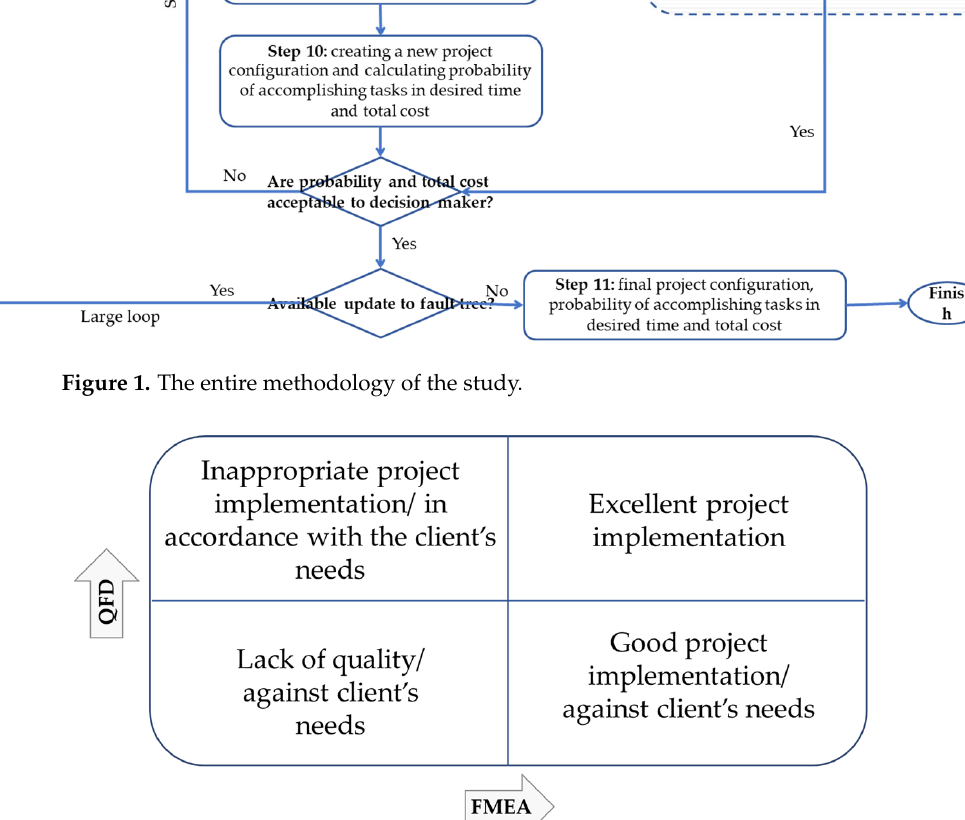
Figure 1. The entire methodology of the study.